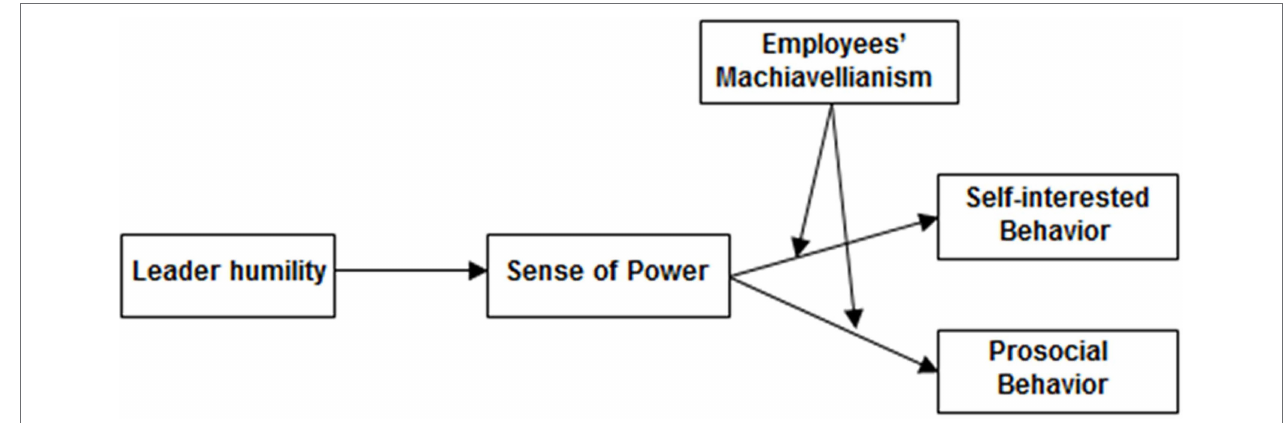
FIGURE 1 | Theoretical